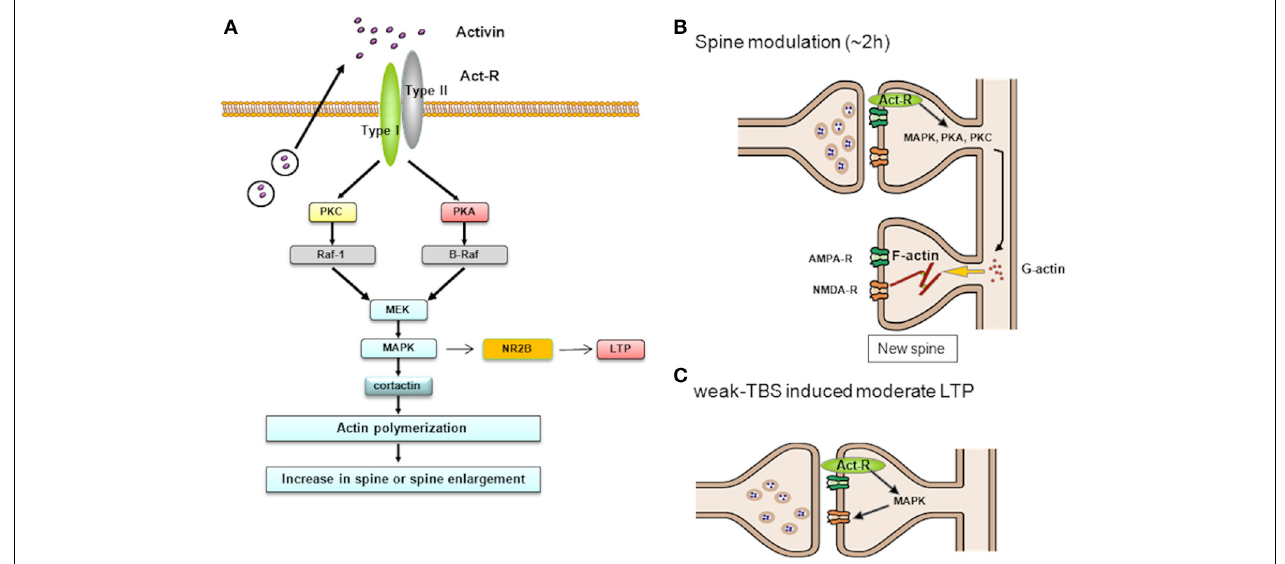
FIGURE 7 | Schematic illustration of activin-induced spinogenesis via multiple kinase pathways. (A) Upon activation by activin receptor complex (ActR), early LTP is suppressed by anti-inflammatory action of activin. (B) After 2h of ActR activation, PKA, PKC and MAPK may